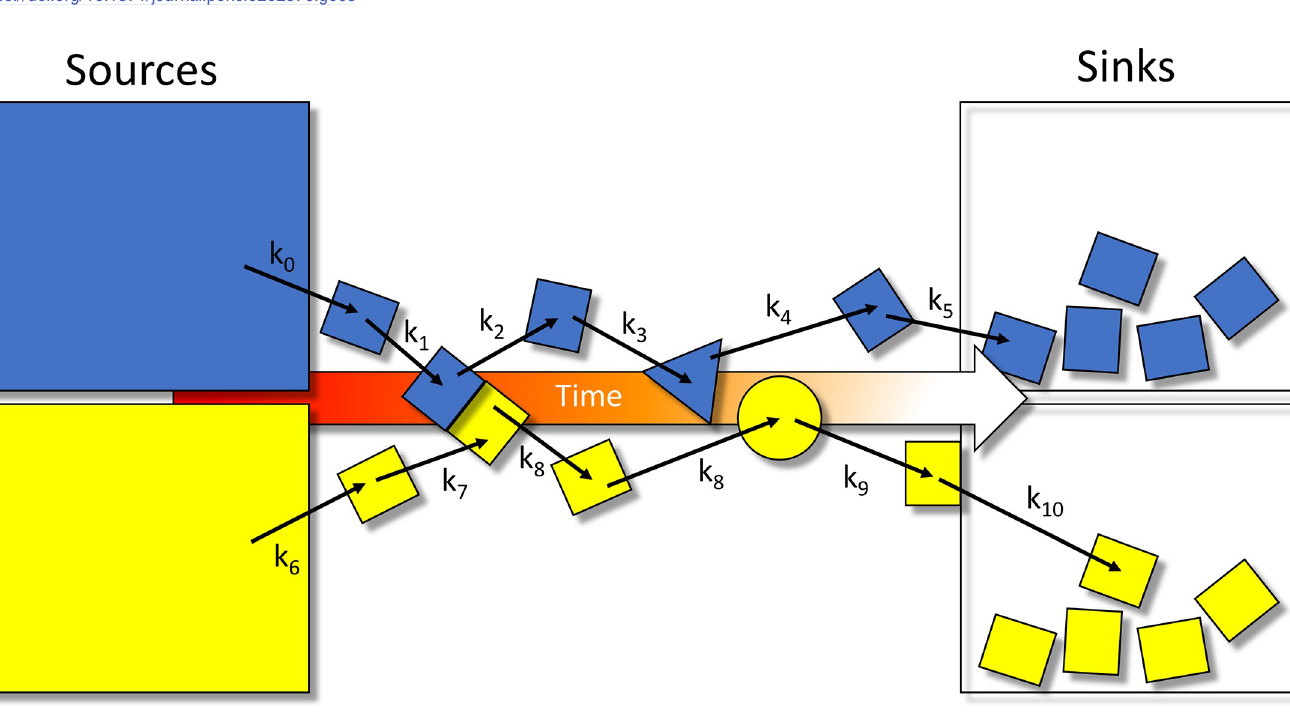
Fig 4. Molecular species and states build and decay transiently (i.e. sources ! sinks), thereby generating non-equilibrium conditions. Such conditions promote unidirectional fluxes on which cellular analog computing is